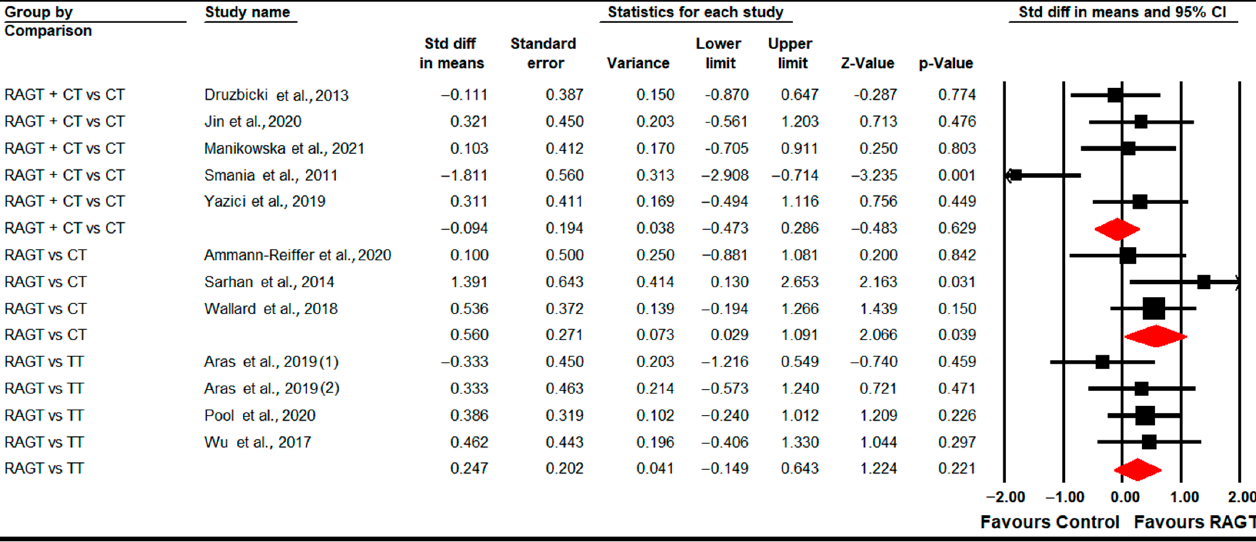
Figure 2. Forest Plot of Gait Speed (Post-Intervention Assessment)